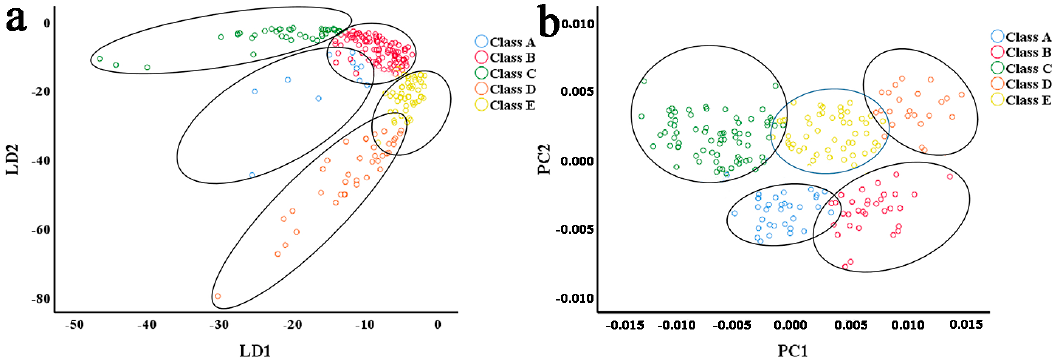
Figure 10. Discriminant analysis plot of multi-category classification models. ( a ) LDA model; ( b ) PCA-SVM model.